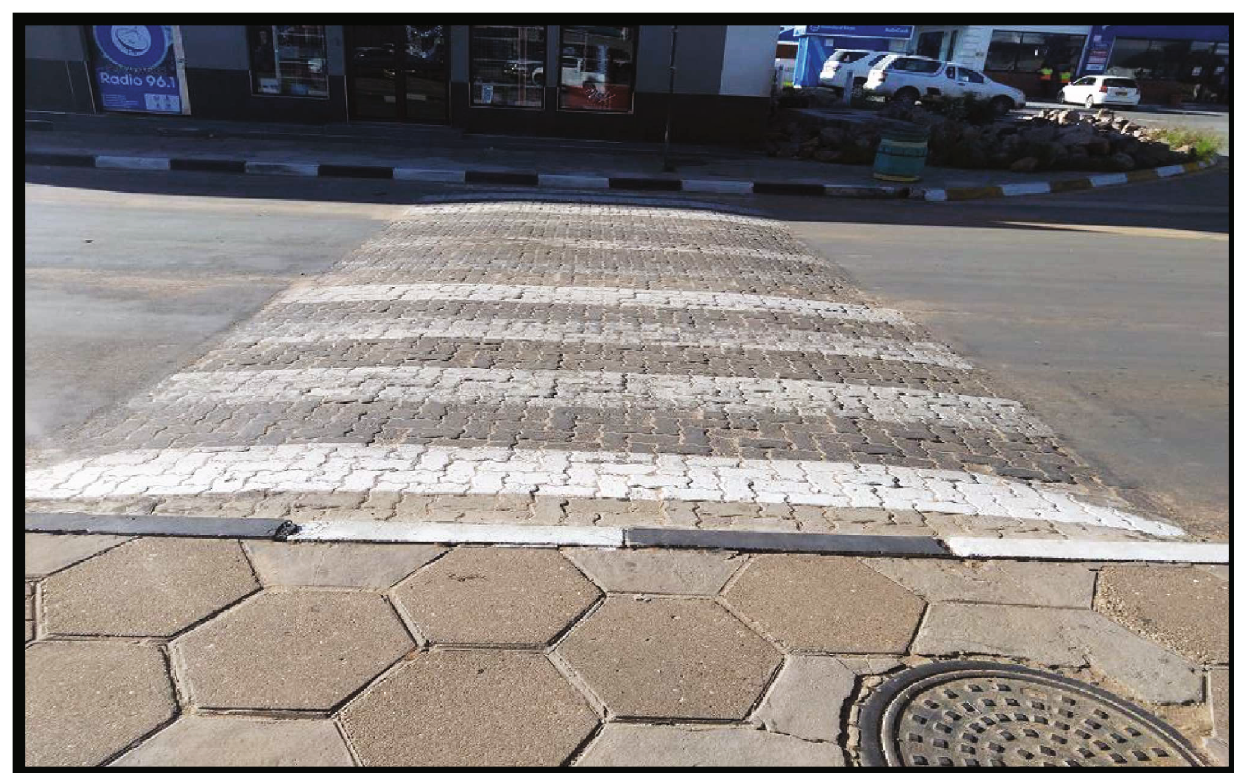
Figure 3: Pedestrian crossing place that lacks inclusivity for wheelchair